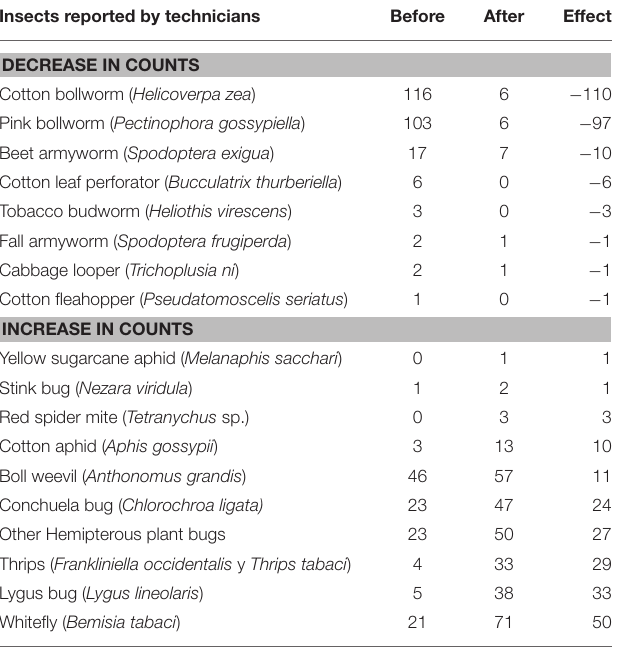
TABLE 1 | Insects reported by technicians as important pests in all regions. Insects reported by